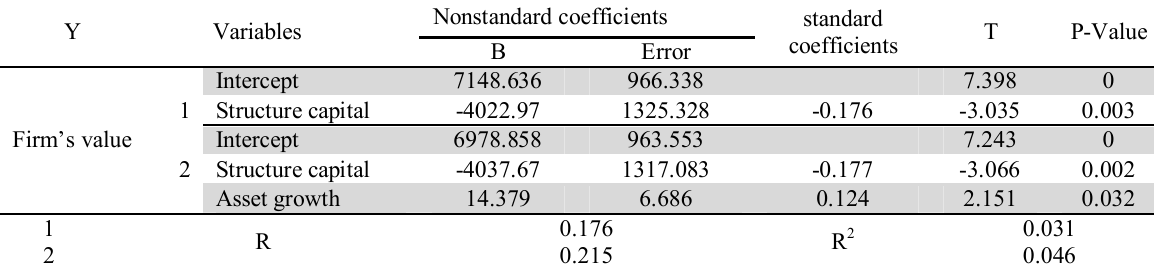
The results of regression